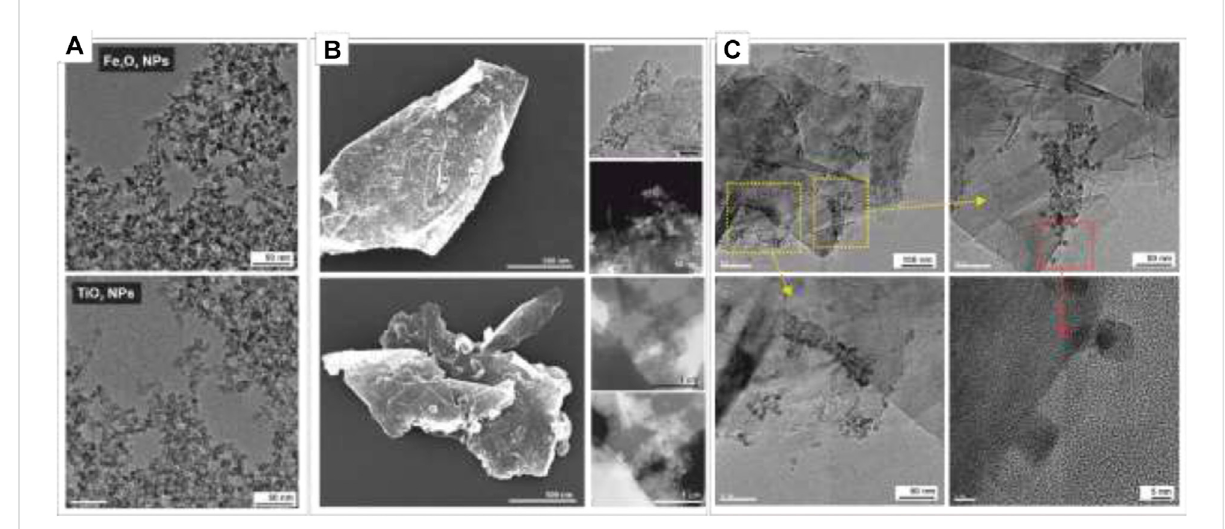
FIGURE 1 Representative Electron Microscopy Images of NPs and NPs/Graphene hybrids structures. (A) Transmission electron microscopy (TEM) images of as-synthetized Fe 3 O 4 and TiO 2 NPs TEM. (B) Scanning Electron Microscopy (SEM), TEM and Scanning Transmission Electron Microscopy (STEM) taken with a high-angle annular dark fi eld (HAADF) detector of GM/Fe 3 O 4 /TiO 2 hybrid nanostructures. (C) High-Resolution TEM (HRTEM) images of GM/Fe 3 O 4 /TiO 2